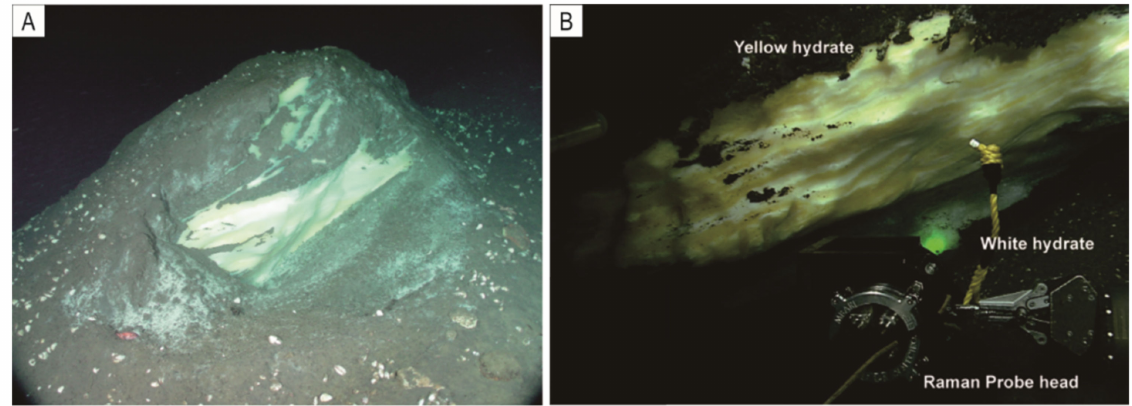
Figure 23. ( A ) Small sediment-covered hydrate pingo (3 m high and 4 m long) showing a slab of exposed hydrate. ( B ) Double mound revealing an exposed hydrate face with both the yellow and white hydrate layers. ( A is cited from [128]; B is cited from